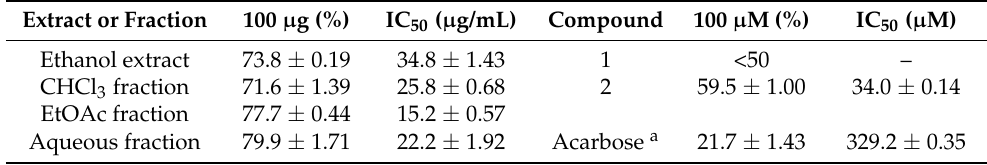
Table 1. α -Glucosidase inhibitory activities of EtOH extract, fractions, and compounds. Extract or Fraction 100 µ g (%) IC 50 ( µ g/mL) Compound 100 µ M (%) IC 50 ( µ M) Ethanol extract 73.8 ± 0.19 – CHCl 3 fraction EtOAc fraction Aqueous